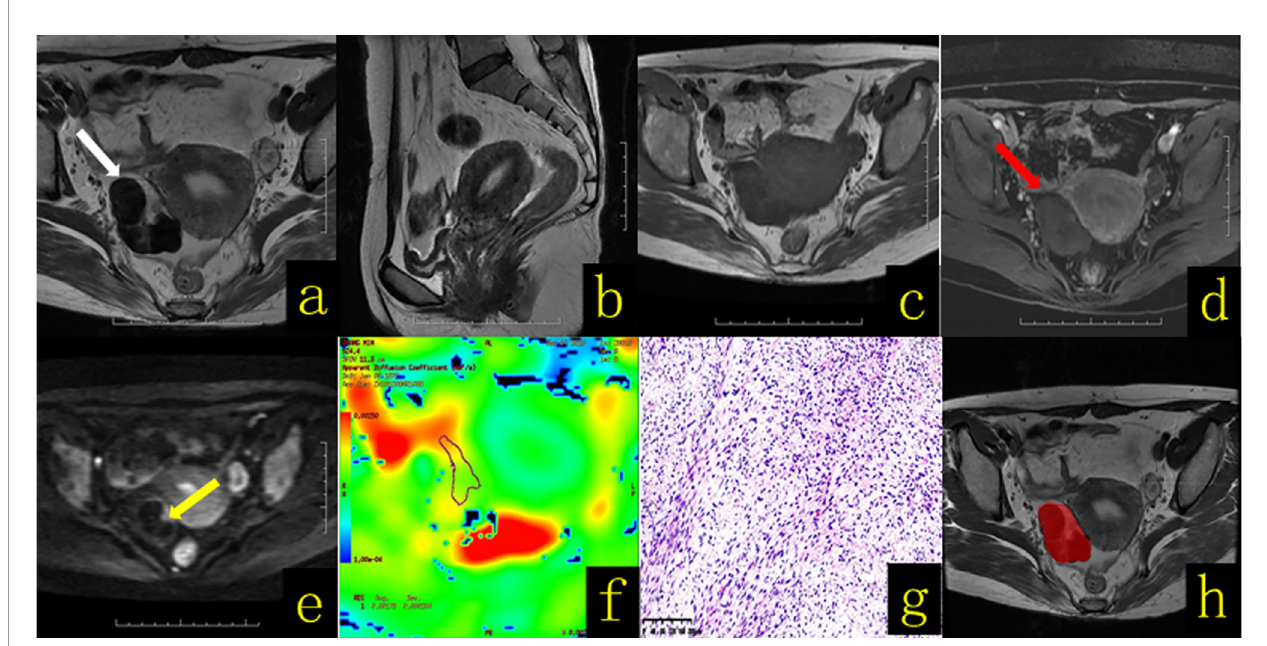
FIGURE 3 | A 65-year-old female patient with right ovarian thecoma – fi brothecoma. (A) Axial T2WI revealed a solid mass in the right adnexal region (white arrow), showing mainly a low-signal mass with a semiarc shape and high signal at the left front edge. (B) Sagittal T2WI showed thickening of the endometrium to a thickness of approximately 1.2 cm. (C) Axial T1WI revealed a solid mass with hypo – isointense signal (white arrow). (D) On contrast-enhanced fat-suppressed T1WI, the solid components (red arrow) of the lesion showed mild enhancement. (E) On DWI-MRI ( b = 1,000 s/mm 2 ), the solid part of the lesion of the left front edge appeared hyperintense (yellow arrow). (F) The apparent diffusion coef fi cient (ADC) map showed that the average ADC value of the diffuse high-signal area was approximately 1.78 × 10 -3 mm 2 /s. (G) Hematoxylin and eosin (H&E) staining (×100) showed that the tumor was composed of spindle cells and collagen fi bers arranged in a mat-like pattern with interwoven bundles, and hyaline degeneration of fi brous tissue bands and intercellular edema were observed to varying degrees. The tumor cell nucleus was fusiform to oval, with sparse cytoplasm and containing a small amount of lipids; the mitotic index was <3/10 HPF. (H) The texture analysis target area was delineated throughout the whole tumor layer by